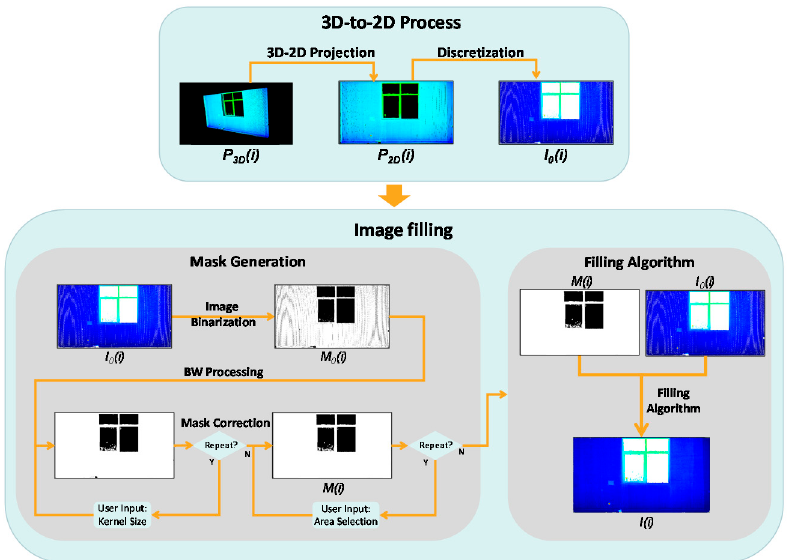
Figure 5. Flowchart showing the generation of the thermal orthoimages of the structural elements. (Up) Generating the coarse orthoimage I 0 (i); (Down) Image filling algorithm.